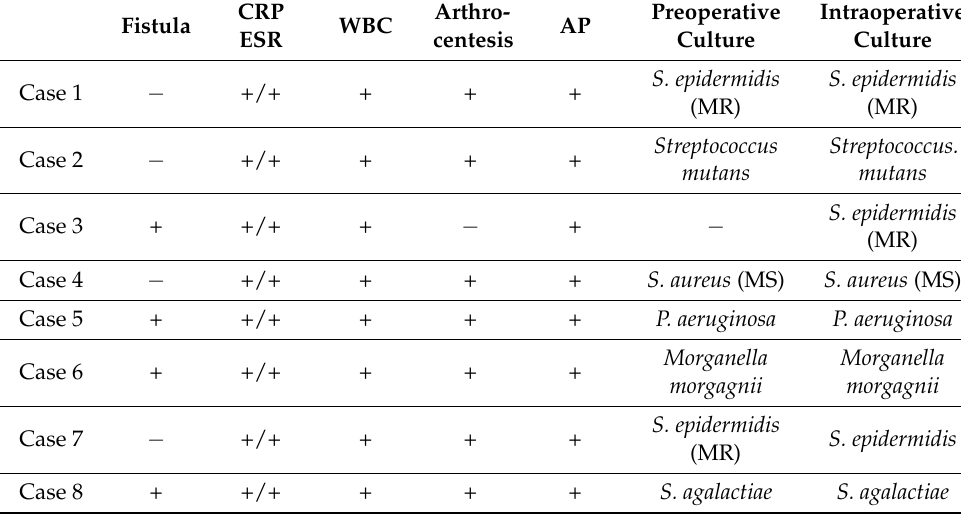
Table 2. Diagnosis of periprosthetic joint infection. CRP: C-reactive protein; ESR: erythrocyte sedimentation rate; WBC: white blood cell count; AP: anatomic pathology; MR: methicillin-resistant; MS